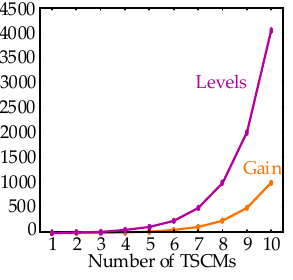
Figure 11. Growth curves of output levels and voltage gain.